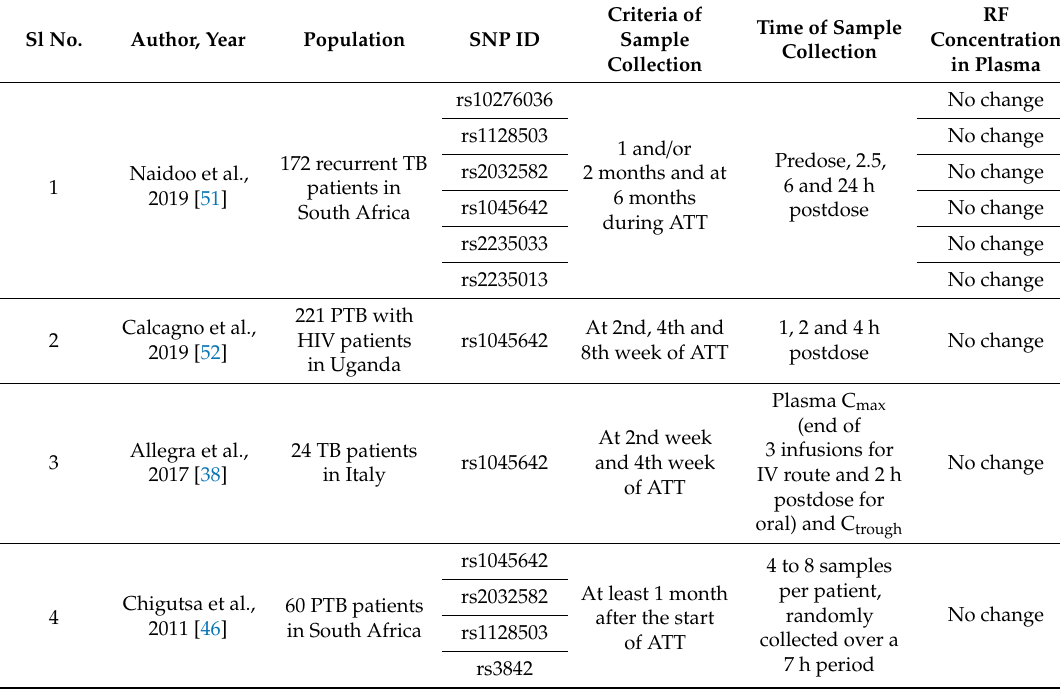
Table 2. Influence of ABCB1 genetic variants on plasma RF